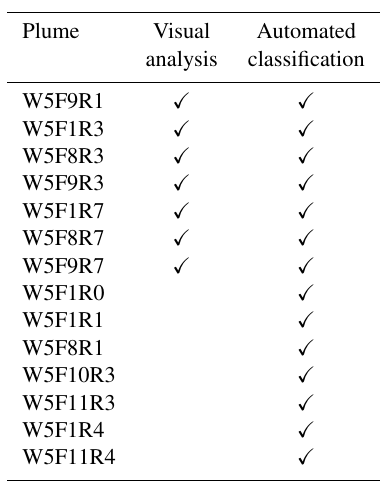
Figure 10. Similarity solution for dimensionless groups H and z , corresponding to the right-hand side (RHS) and left-hand side (LHS) of Eq. (13), respectively. Scatter points represent individual LES runs, colored by fireline intensity parameter I . Table 3. Identifying non-penetrative plumes using visual analysis vs. automated classification. Plume name denotes wind condition W , fuel type F and initial atmospheric profile R